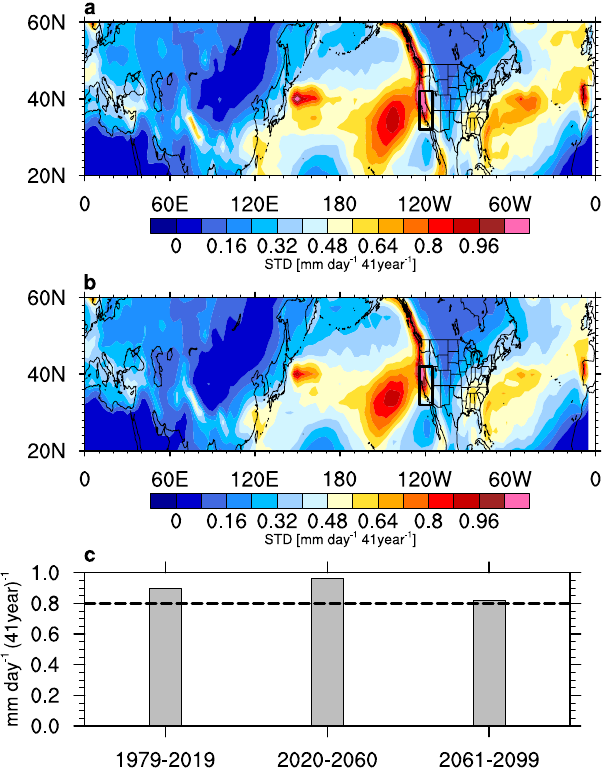
Fig. 1 Effect of internal variability on the large uncertainty of winter precipitation decadal trends over California. a Total uncertainty of winter precipitation trend during 1979 – 2019 based on the 128 members of CMIP5 and CMIP6 (CMIPs). b Internal uncertainty based on the average of intermember standard deviation (STD) from three large ensembles (including 100 MPI-ESM, 40 CESM1, and 50 CanESM2 simulations). c Fraction of the total uncertainty in California winter precipitation trend during 1979 – 2019, 2020 – 2060, 2061 – 2099 explained by internal variability based on the average of three large ensembles. Units: mm day − 1 41year − 1